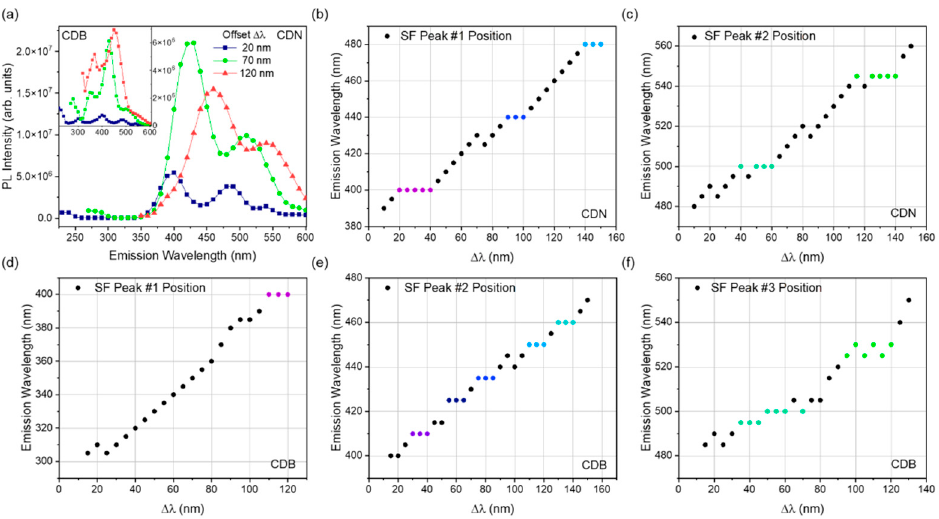
Figure 9. ( a ) SF emission plots at different offsets for CDB (inset) and CDN. ( b – f ) Emission wave- length of the peak as a function of the offset. of the peak as a function of the